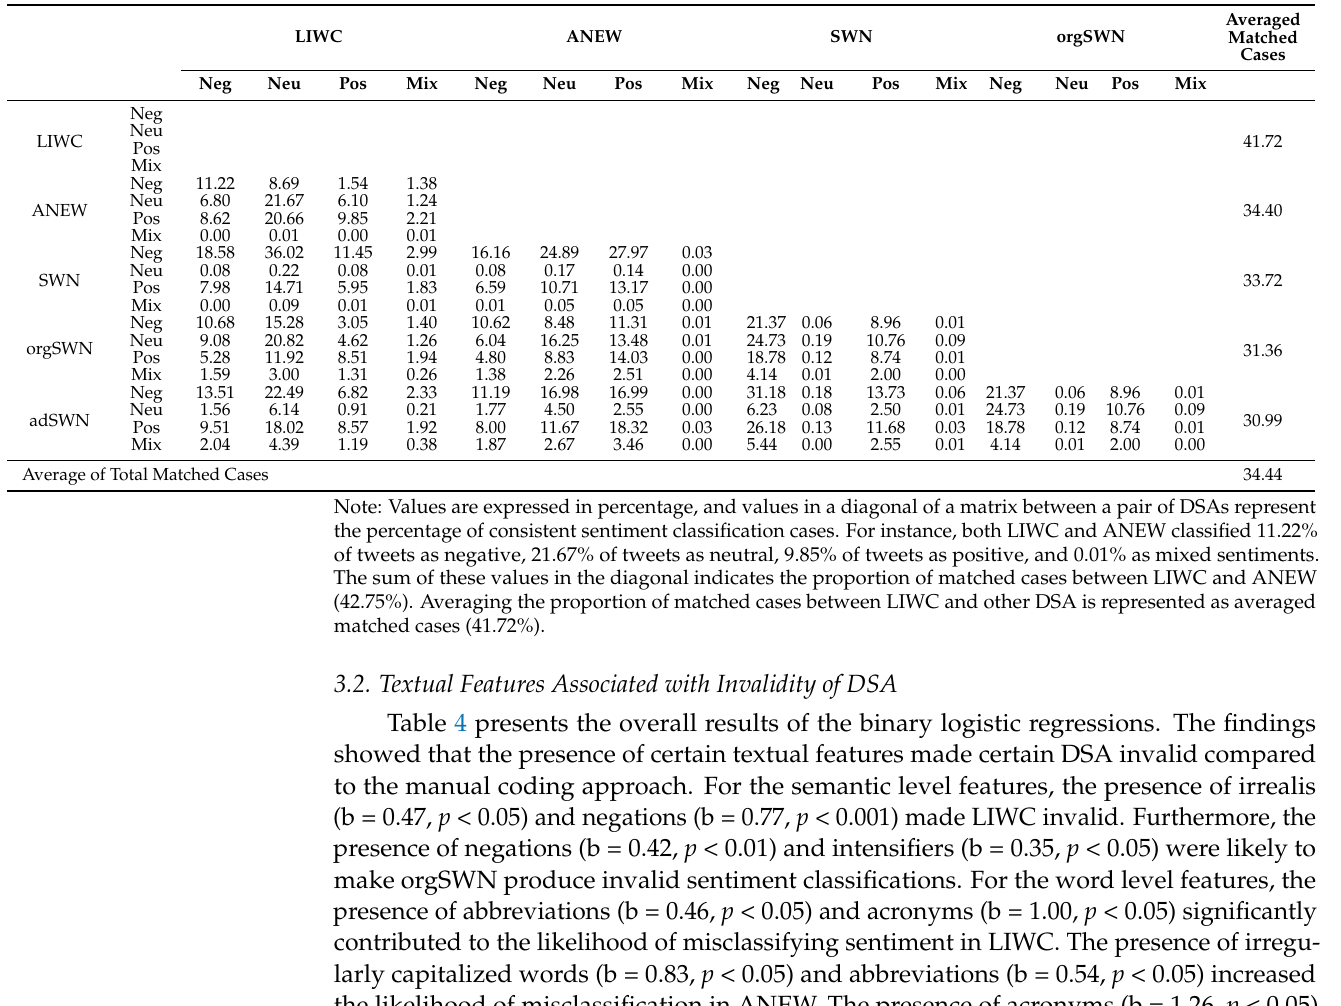
Table 3. Sentiment classification comparison among